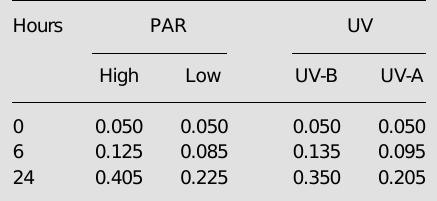
Table 1 - Effects of UV-B, UV-A and different levels of PAR on the specific activity of NADP-ME from etiolated